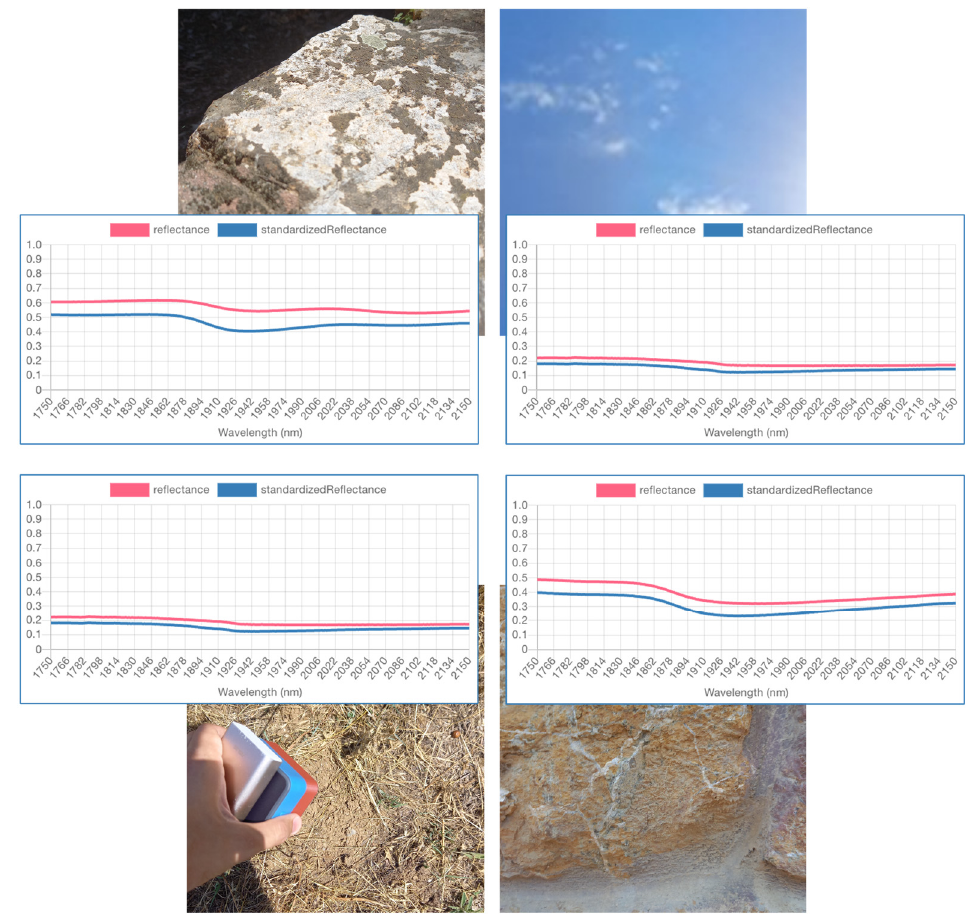
Figure 4. Instances of the collection of non-soil objects for the outlier dataset creation and their reflectance spectra before and after standardization.